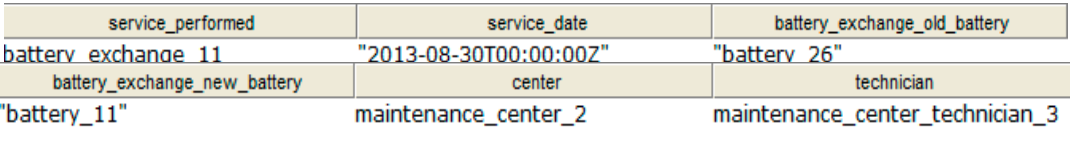
Figure 15. Output produced by Protégé according to the query description.